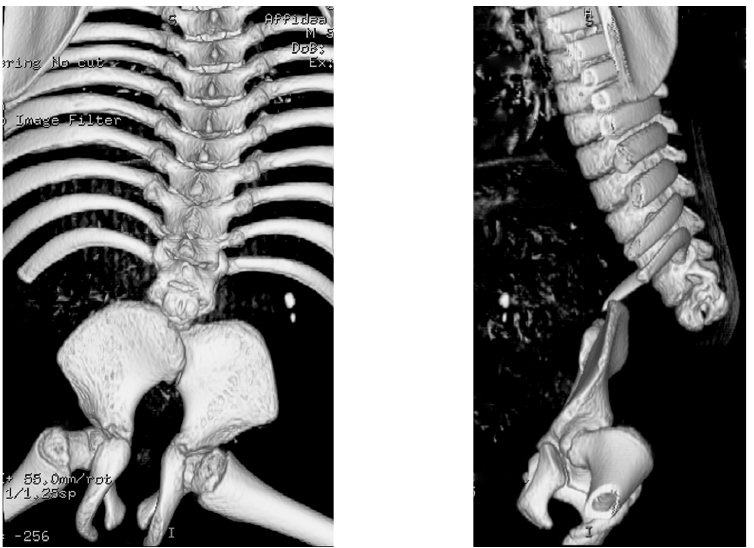
Figure 5. CRS. CT scans of spine and pelvis in total agenesis of sacrum and lower lumbar vertebra.